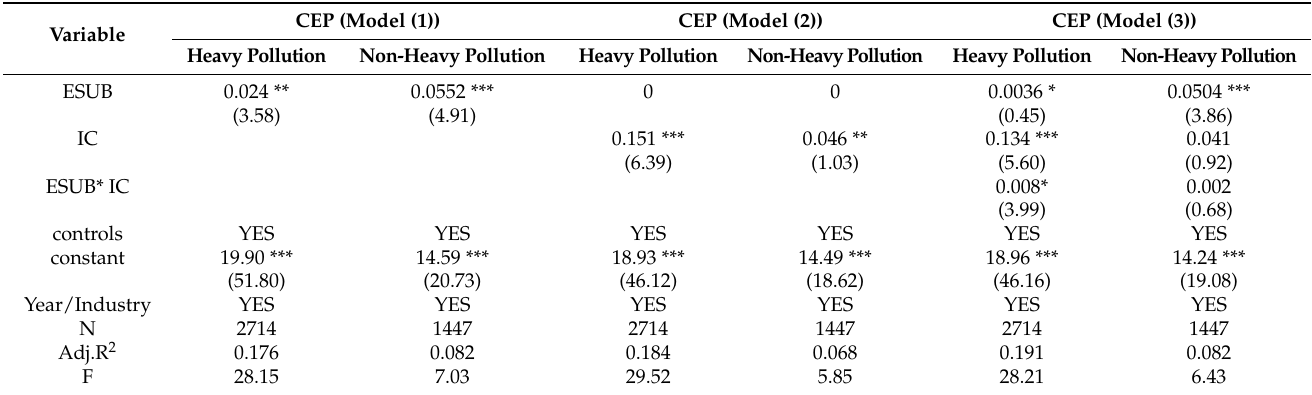
Table 5. Industry categorical regression analysis of heavy and non-heavy pollution.